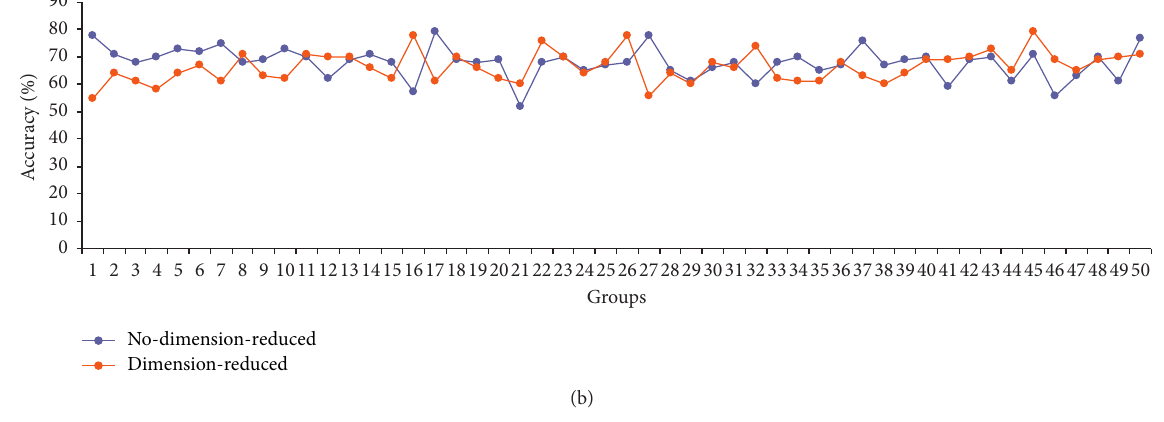
Figure 14: Comparison curve of time and accuracy of entity semantic fusion without dimension reduction and dimension reduction. (a) Comparison of running time and (b) comparison of